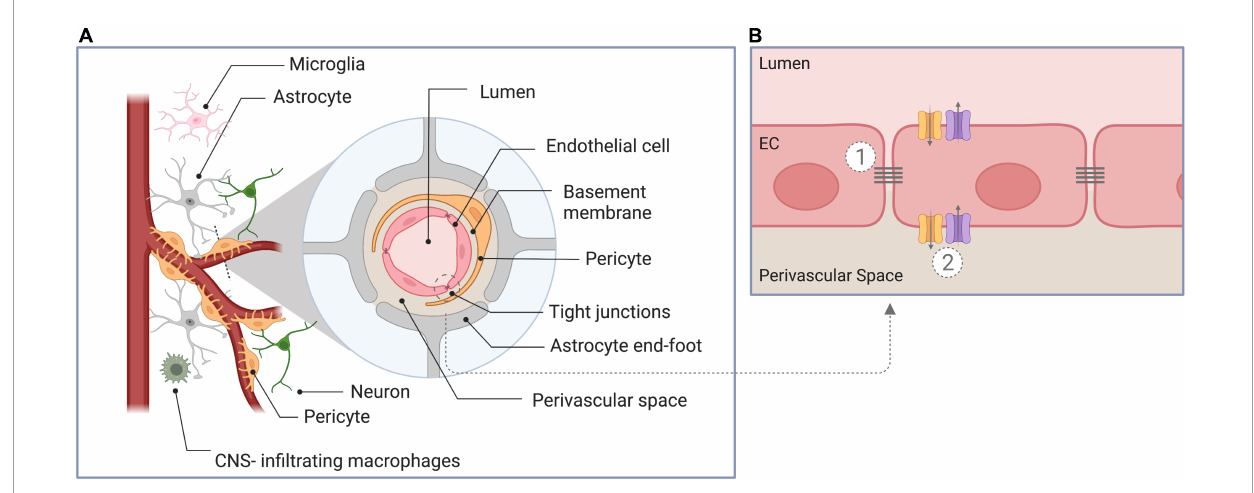
FIGURE1 Schematic overview of components of the blood-brain barrier. (A) Cross-section through the neurovascular unit, consisting of endothelial cells, pericytes, astrocytes, the basement membrane, neurons, and immune cells. (B) Illustration of the unique properties of the blood-brain barrier endothelial cells: (1) The presence of intercellular tight junctions and the absence of fenestration limiting paracellular diffusion, and (2) the presence of specific transporters to regulate in- and efflux of substrates (transcellular transport). EC, endothelial